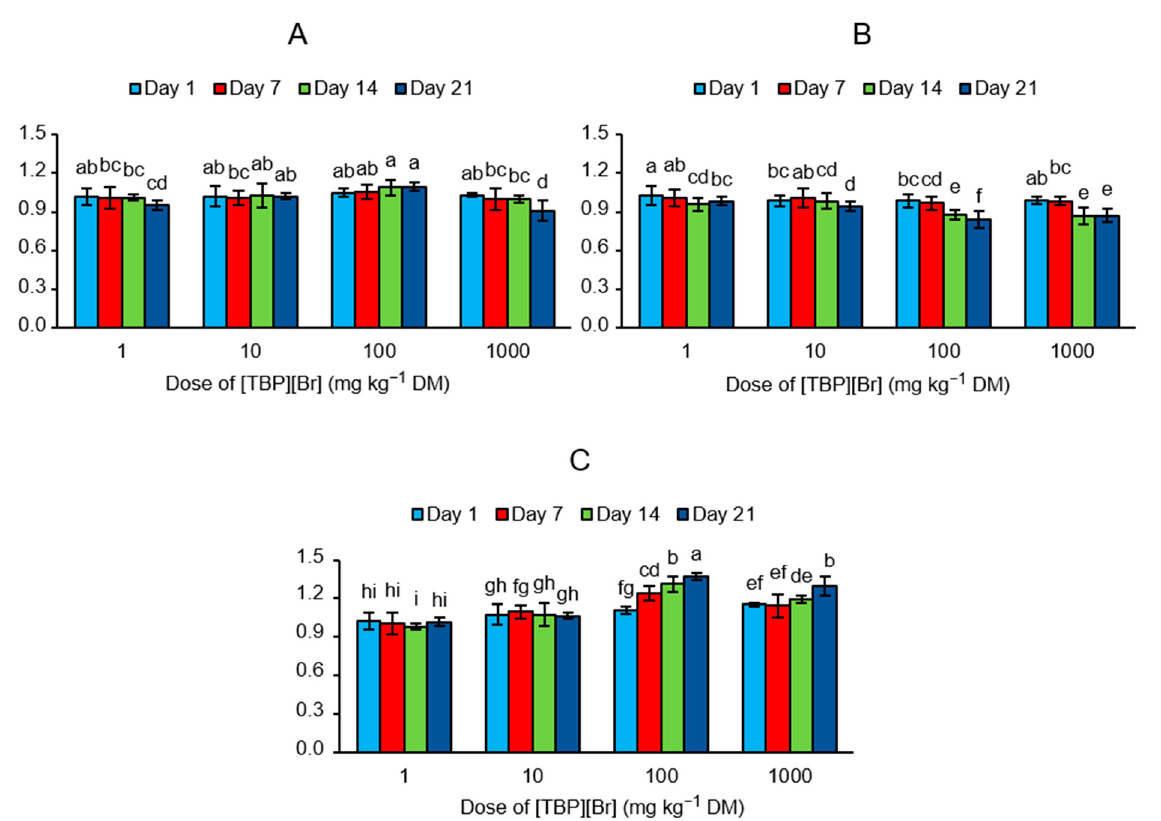
Figure 4. Values of enzyme activity indices ( EAI ) determined for the soil exposed to tetrabutylphosphonium bromide [TBP][Br] in pot experiment with spring barley: ( A ) carbon cycle, ( B ) phosphorus cycle, ( C ) nitrogen cycle; data are presented as mean ± SD; values denoted by the same letters for each enzyme do not differ significantly on the level of p = 0.05 (Tukey HSD test).